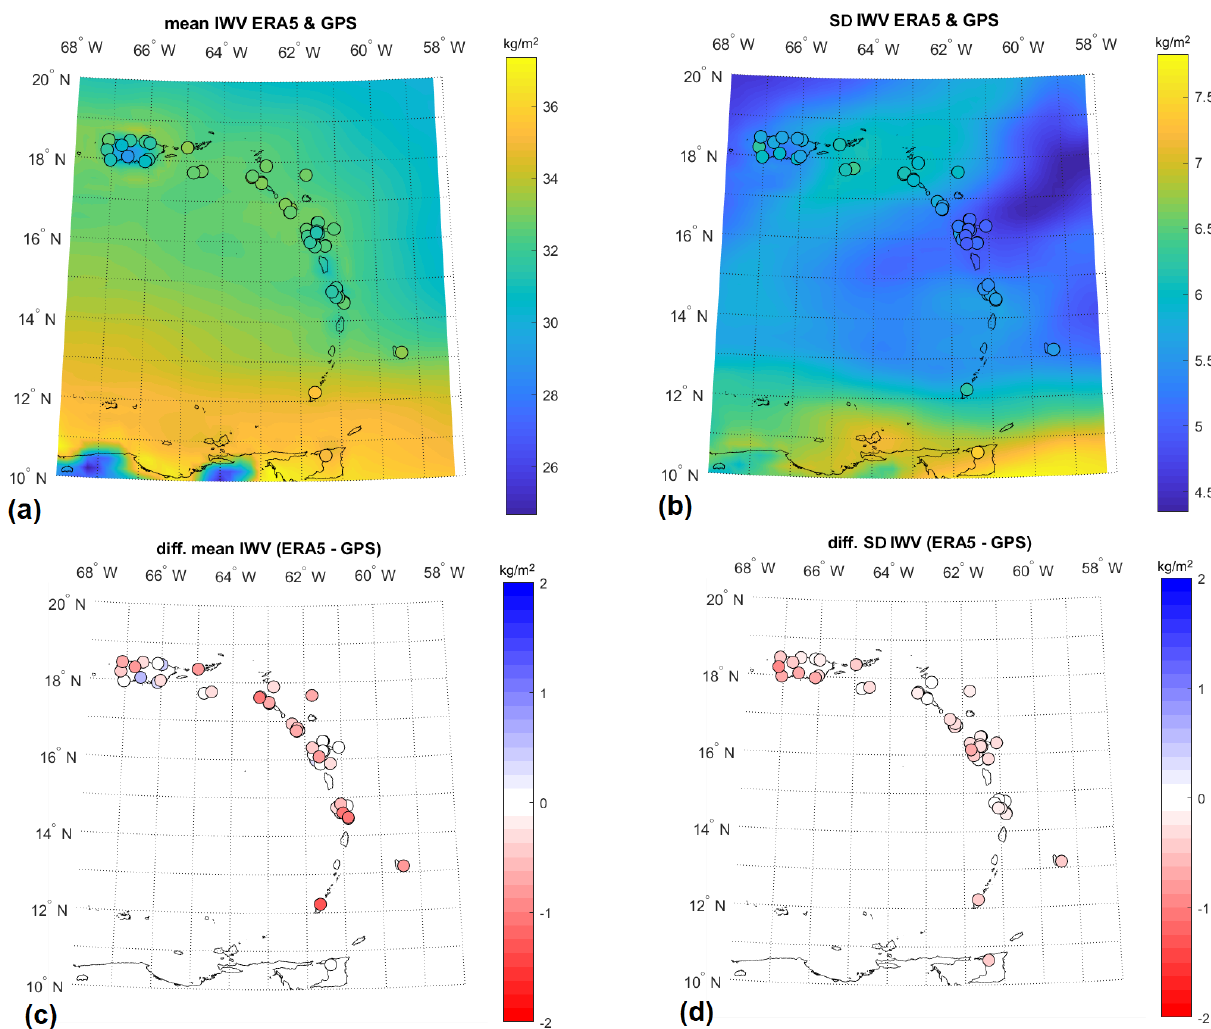
Figure 8. (a, b) Mean and standard deviation of hourly IWV from ERA5 (background) and GNSS (circles) from 1 January to 29 Febru- ary 2020. (c, d) Difference of mean and standard deviation of hourly IWV values (ERA5 − GNSS). In panels (a) and (b) , the GNSS IWV data have been height corrected and gaps have been filled with ERA5 values to minimize representativeness differences. In panels (c) and (d) , ERA5 IWV data have computed from pressure-level profiles from the height of the GNSS stations upwards (no correction applied to GNSS IWV